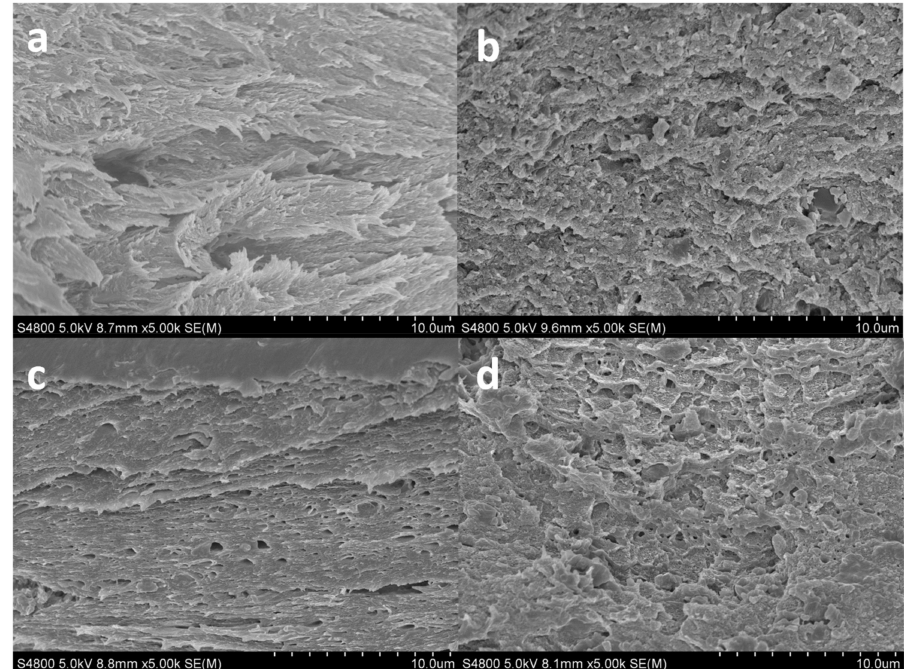
Figure 7. SEM images of the cross-section of collagen scaffolds: ( a ) control; ( b ) THC2; ( c ) THC4; and ( d ) THC6.